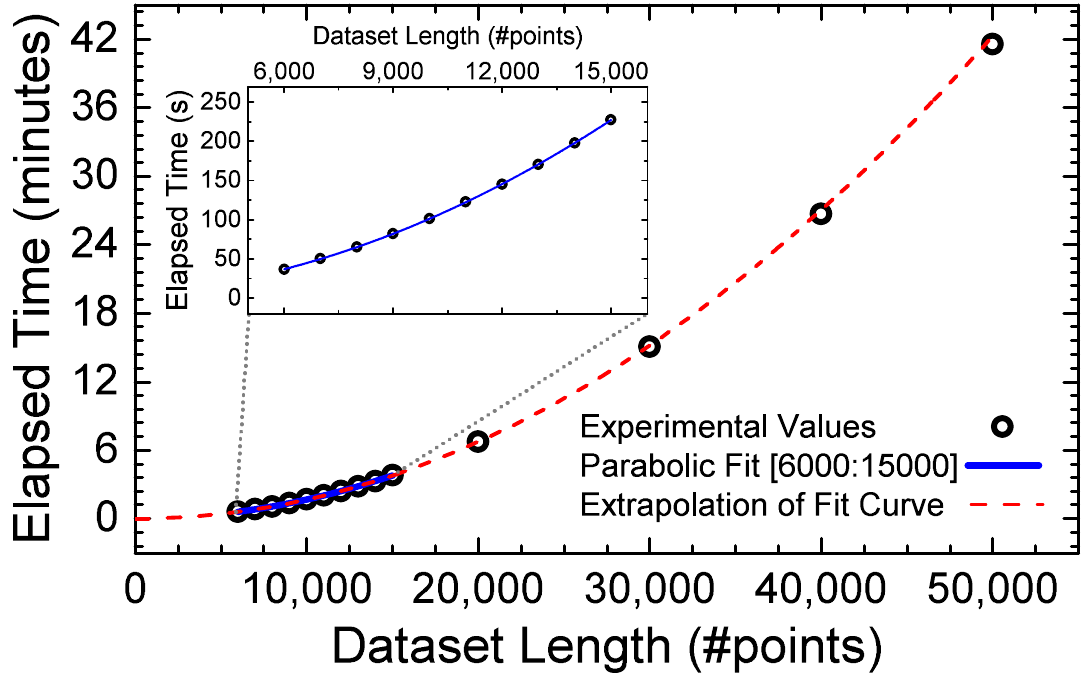
Figure 2. Elapsed times of the LBI algorithm for different dataset lengths. Following the complexity analysis of the algorithm, a parabolic curve is fitted to the first ten points of the curve (6000 to 15,000 points, marked in blue) and further extrapolated to the higher values. As can be seen, the curves fall exactly into the extrapolated curve, confirming the complexity